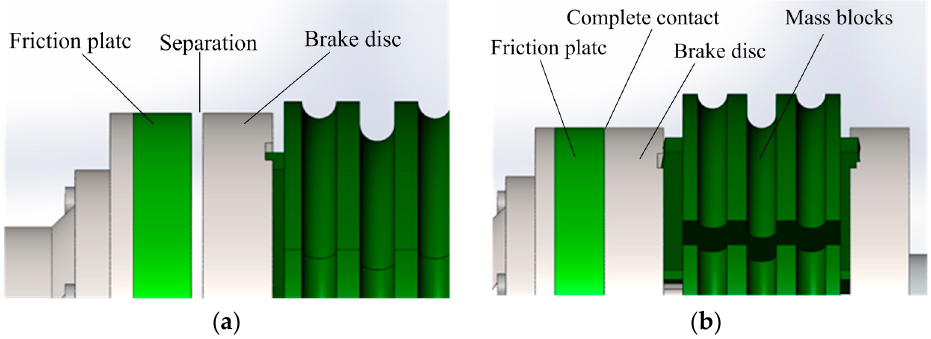
Figure 4. Movement state of the recovery mechanism. ( a ) Low-speed movement of the robot; ( b ) High-speed movement of the robot.